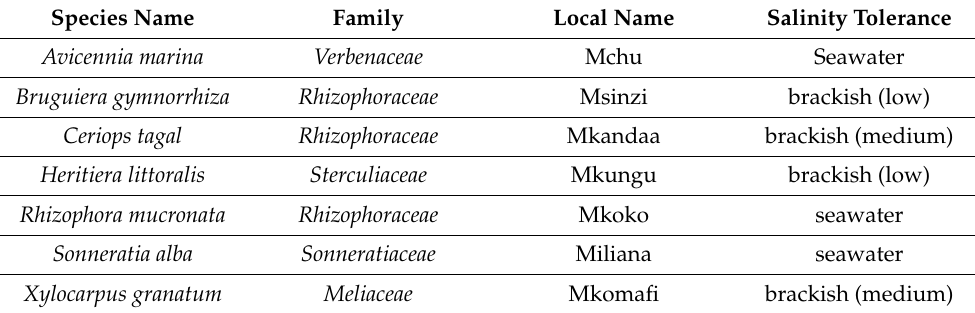
Table 2. Mangrove species occurring in Wami Estuary,